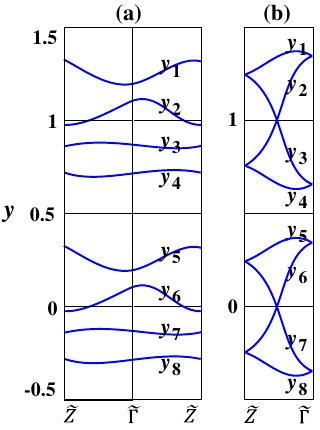
FIG. 5. Comparison of the spectrum of P ⊥ ˆ yP ⊥ for a system without any symmetry (a) and one with time-reversal, spatial- inversion, and glide symmetries (b). Only the spectrum for two spatial unit cells is